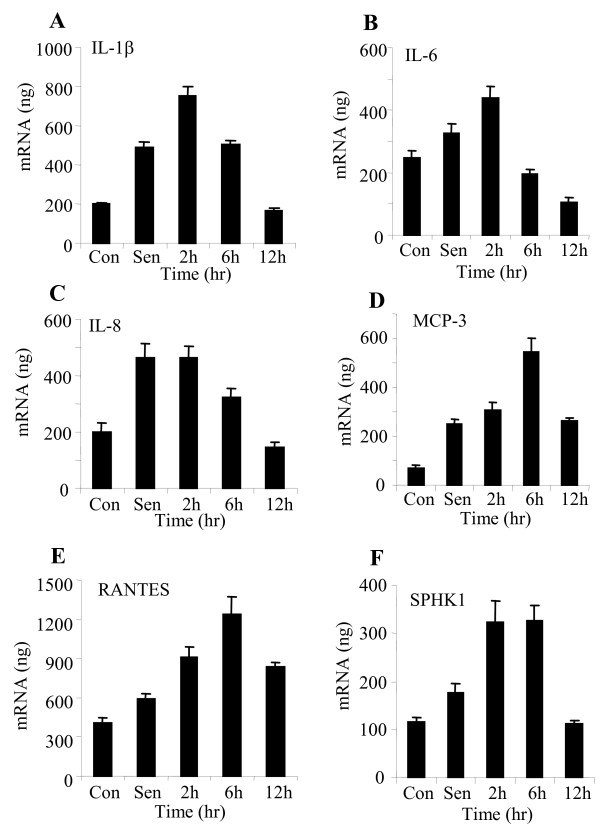
Real-Time PCR of selected genes. Comparison of gene expression from control/resting mast cells (Con); after mast cells were sensitized by human IgE (Sen), and following a time course of FcεRI aggregation for 2 hours (2 h), 6 hours (6 h) and 12 hours (12 h). 1 μg of total RNA was used from the same sample which has been used for microarray experiments at different time points for Light-Cycler Real-Time PCR. The concentrations of these transcripts were calculated using respective standard curves. (A) IL-1β expression; (B) IL-6 expression; (C) IL-8 expression; (D) MCP3 expression; (E) RANTES expression; and (F) SPHK1 expression. The data represent average ± the standard deviation of four different samples.